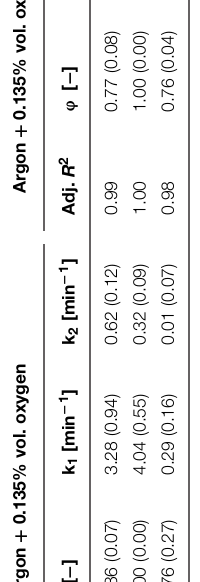
DNA damage followed by a retarded damage of DNA. The use of pure argon resulted in the highest inactivation of 2.8 log 10 and also in the highest DNA damage with a ratio of 0.51. The shift from the accelerated first inactivation phase to the second one was at 1.9 min, whereas the shift between these phases was already at 0.1 min for DNA damage kinetic. Plasma running with argon + 0.135% vol. oxygen + 0.2% vol. nitrogen achieved after 5 min treatment an inactivation and DNA damage ratio value of 2.5 log 10 and 0.57, respectively. The DNA damage showed a linear behavior, because k 1 and k 2 had the same value. The shift to the second inactivation phase was after 0.4 min. Argon + 0.135% vol. oxygen as a feed gas composition inactivated up to 2.4 log 10 endospores and the resulting DNA damage ratio was the highest with 0.63. For DNA damage kinetic no point of inflection could be calculated, since ϕ was smaller than 0.5. The shift between the two inactivation phases was at about 1.0